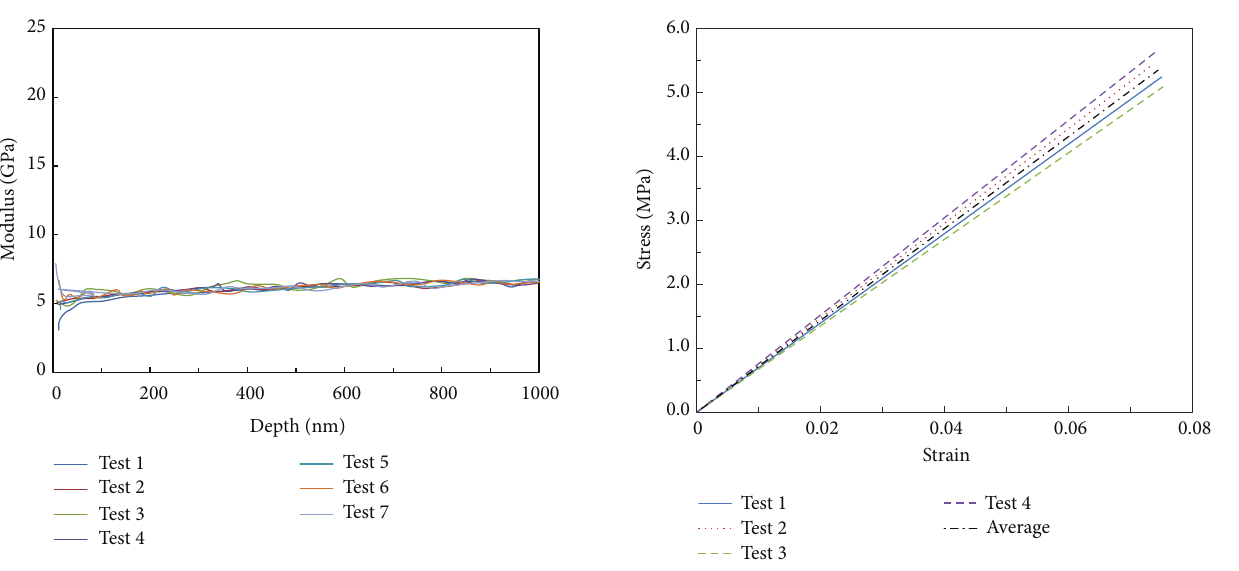
Figure 6: Reduced modulus of the organic PR material versus indentation depth.